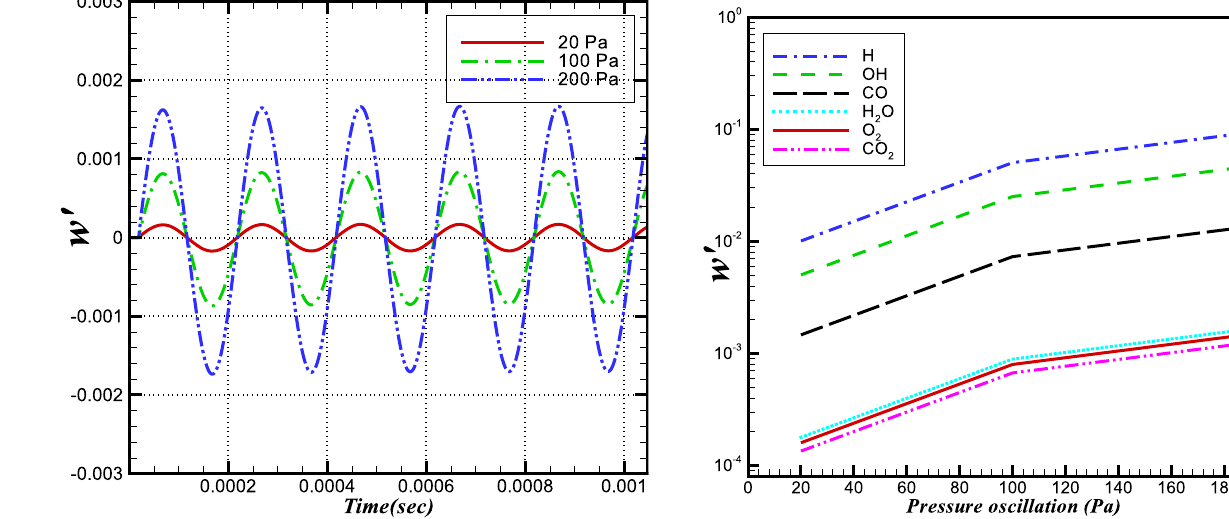
Figure 13. Relative change in the reaction rates of different species at a constant frequency of 5